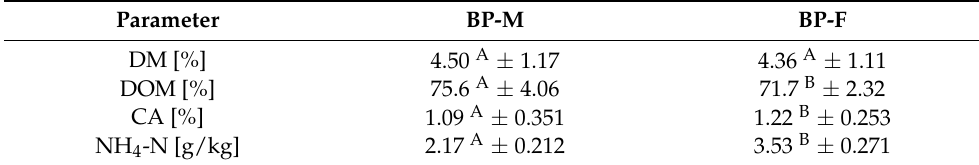
Table 4. The basic composition of post-fermentation residues from the biogas